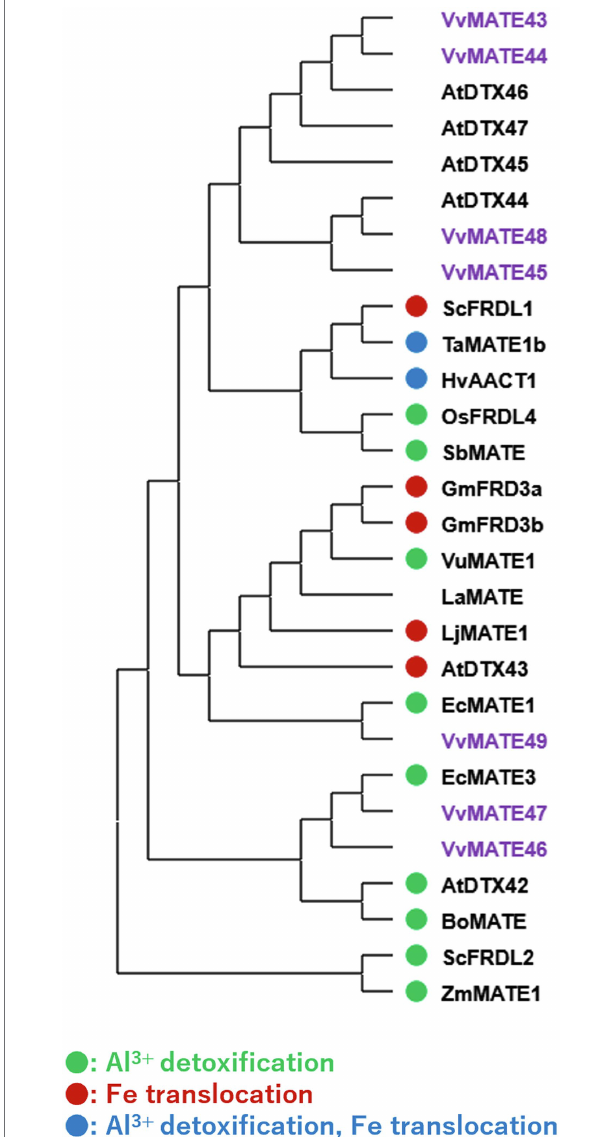
FIGURE 5 | Phylogenetic tree of the group 3 MATEs of grape, Arabidopsis, and those of other plant species reported previously. Amino acid sequences of the MATEs of grape and those of other plant species (Li et al., 2002; Takanashi et al., 2014) were aligned using the ClustalW program. The phylogenetic tree was created by MEGAX using the neighbor-joining model. The group3 of grape MATEs are indicated with purple. MATEs with circle are reported their substrate previously (different colors show different substrates, Takanashi et al.,